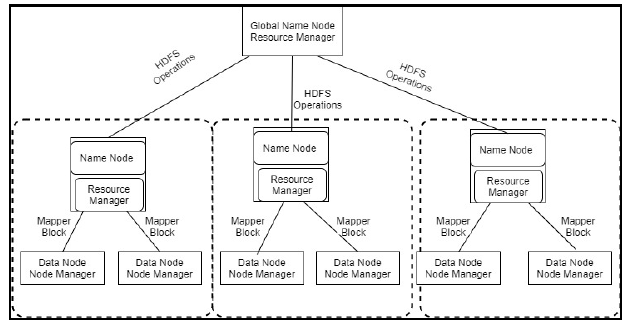
Fig. 3: Block diagram Hierarchical Hadoop Cluster